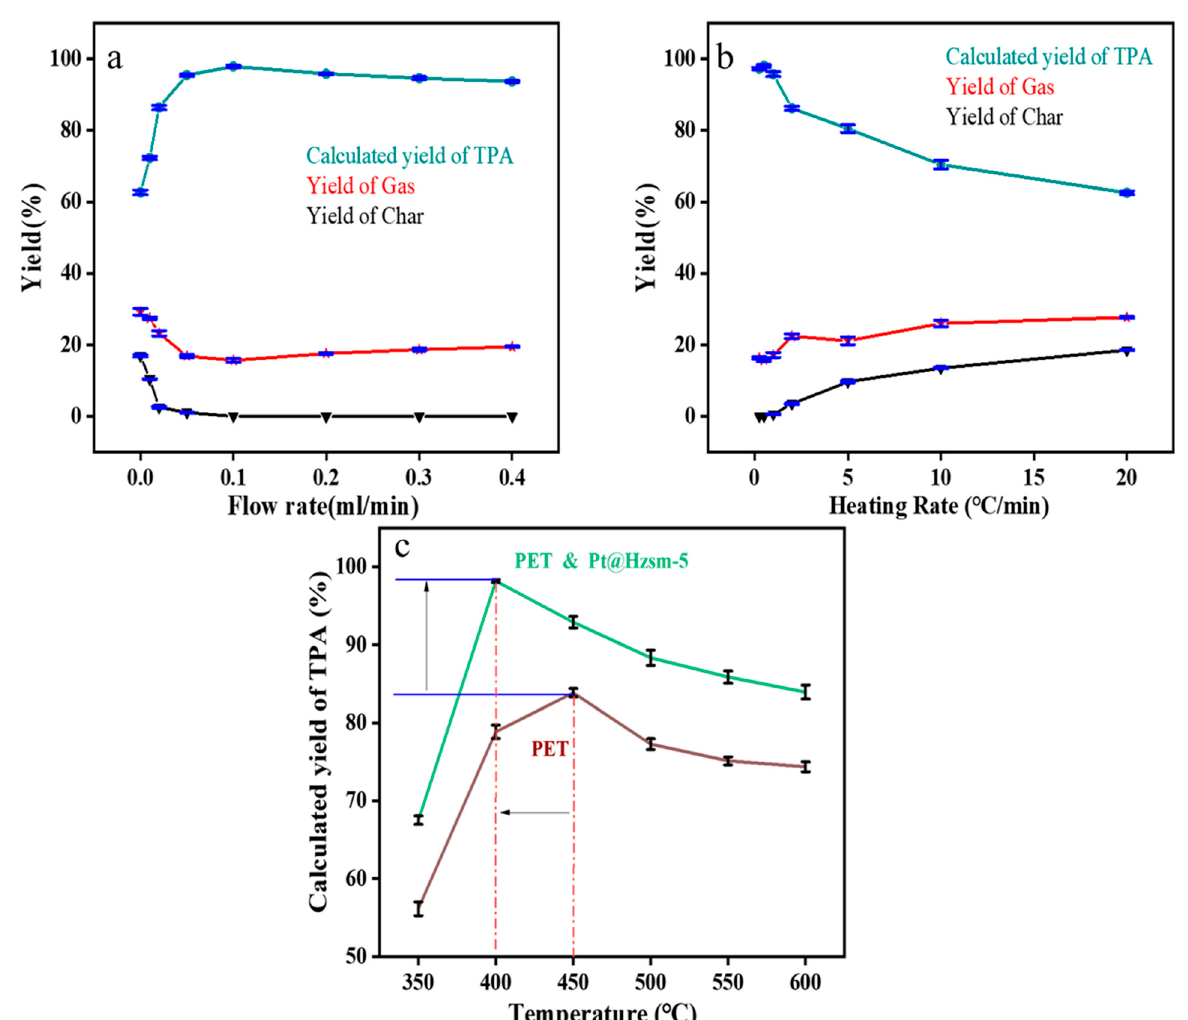
Figure 4. Optimization of the reaction conditions: ( a ) effect of the flow rate on the reaction products; ( b ) effect of the water heating rate on the reaction products; ( c ) effect of the temperature on the reaction products (The red line is the optimal temperature of the two groups of reactions).